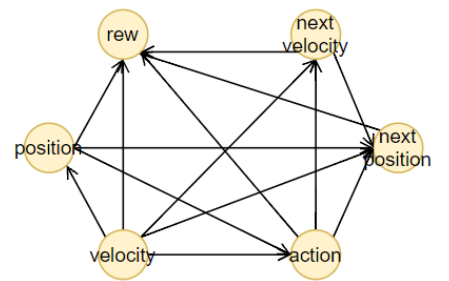
Figure 14. Structure of the BN for the Mountaincar environment. The names of the nodes represent the following features: “position” is the position of the car, “velocity” is the velocity of the car, “action” is the action, “next position” is the next position of the car, “next velocity” is the next velocity of the car and “rew” is the reward. Table 3. AUROC and accuracy for the prediction of each future feature in the Mountaincar environment.